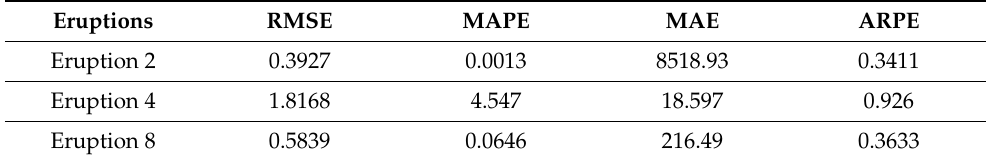
Table 7. Results from system of IG(a,b) OU model. The results reported are the best results from modeling a combination of eruptions 2, eruptions 4 and eruptions 8.